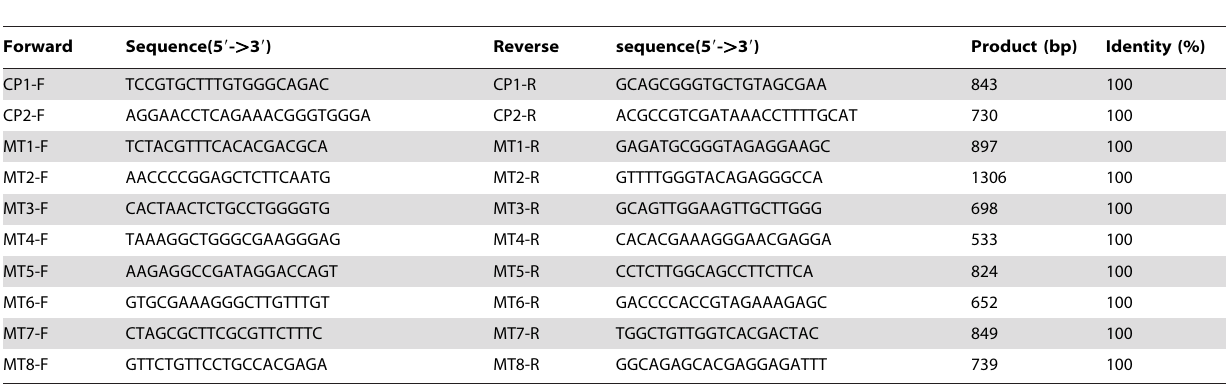
Table 7. Primer pairs used for assembly validation by PCR using Sanger sequencing.